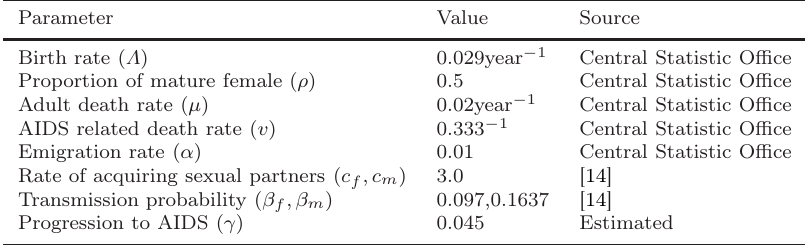
Table 1. Data for the sex-structured HIV/AIDS